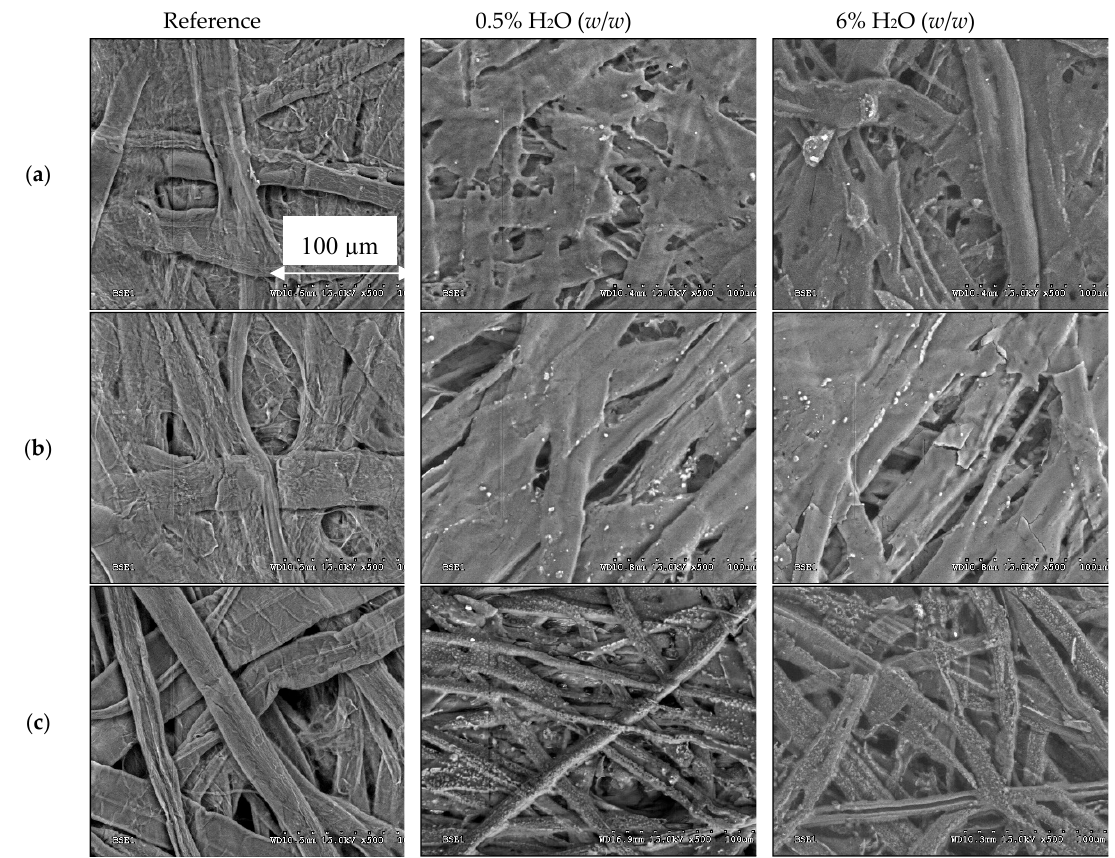
Figure 2. SEM analysis samples: ( a ) Clupak, ( b ) Munksjö Thermo70 and ( c ) Mannitherm D irradiated at laser energy of 310 mJ for 3 min [26].